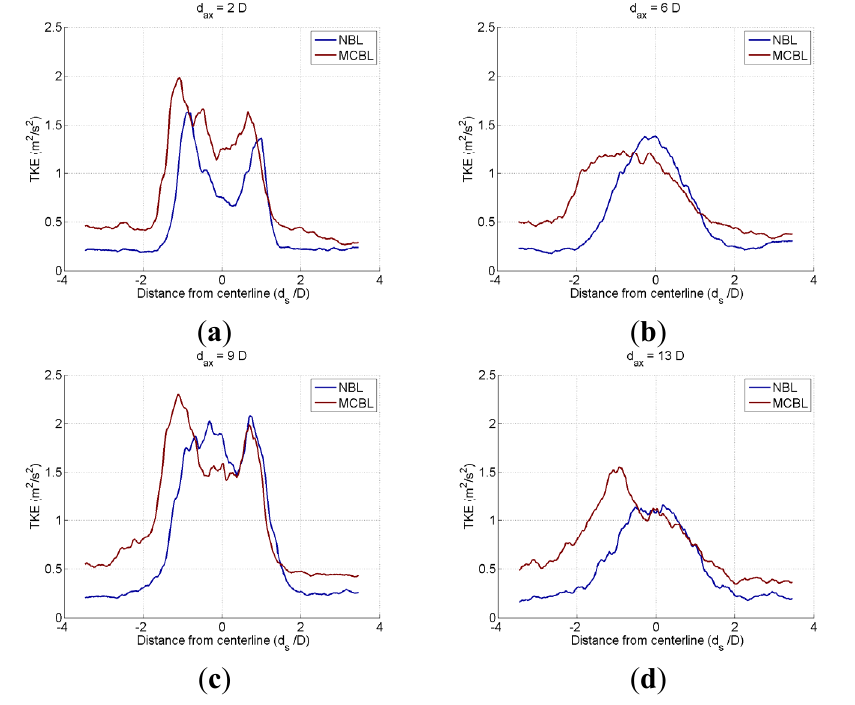
Figure 14. Turbulent Kinetic Energy (TKE) distribution in the spanwise direction at hub height. (Turbine-Turbine Interaction Problem, V Wind = 8 m/s). ( a ) 2D downstream of Turbine 1; ( b ) 6D downstream of Turbine 1; ( c ) 2D downstream of Turbine 2; ( d ) 6D downstream of Turbine